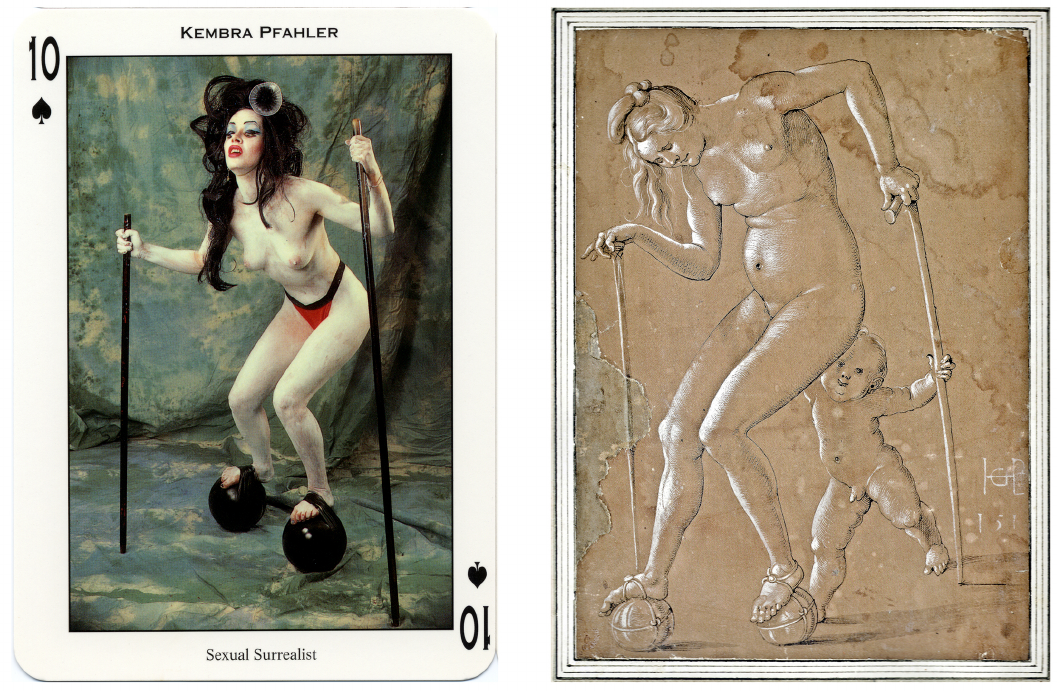
Figure 20. ( Left ) Kembra Pfahler, The Bowling Ball Piece , 1993. Photo by Annie Sprinkle (from Annie Sprinkle’s Post-Modern Pin-Ups: Pleasure Activist Playing Cards . Richmond, VA: Gates of Heck, 1995). ( Right ) Hans Baldung, Nude Walking on Balls , 1514, pen, washed and heightened in white, on brown paper, 27 × 19.5 cm, Graphische Sammlung Albertina,